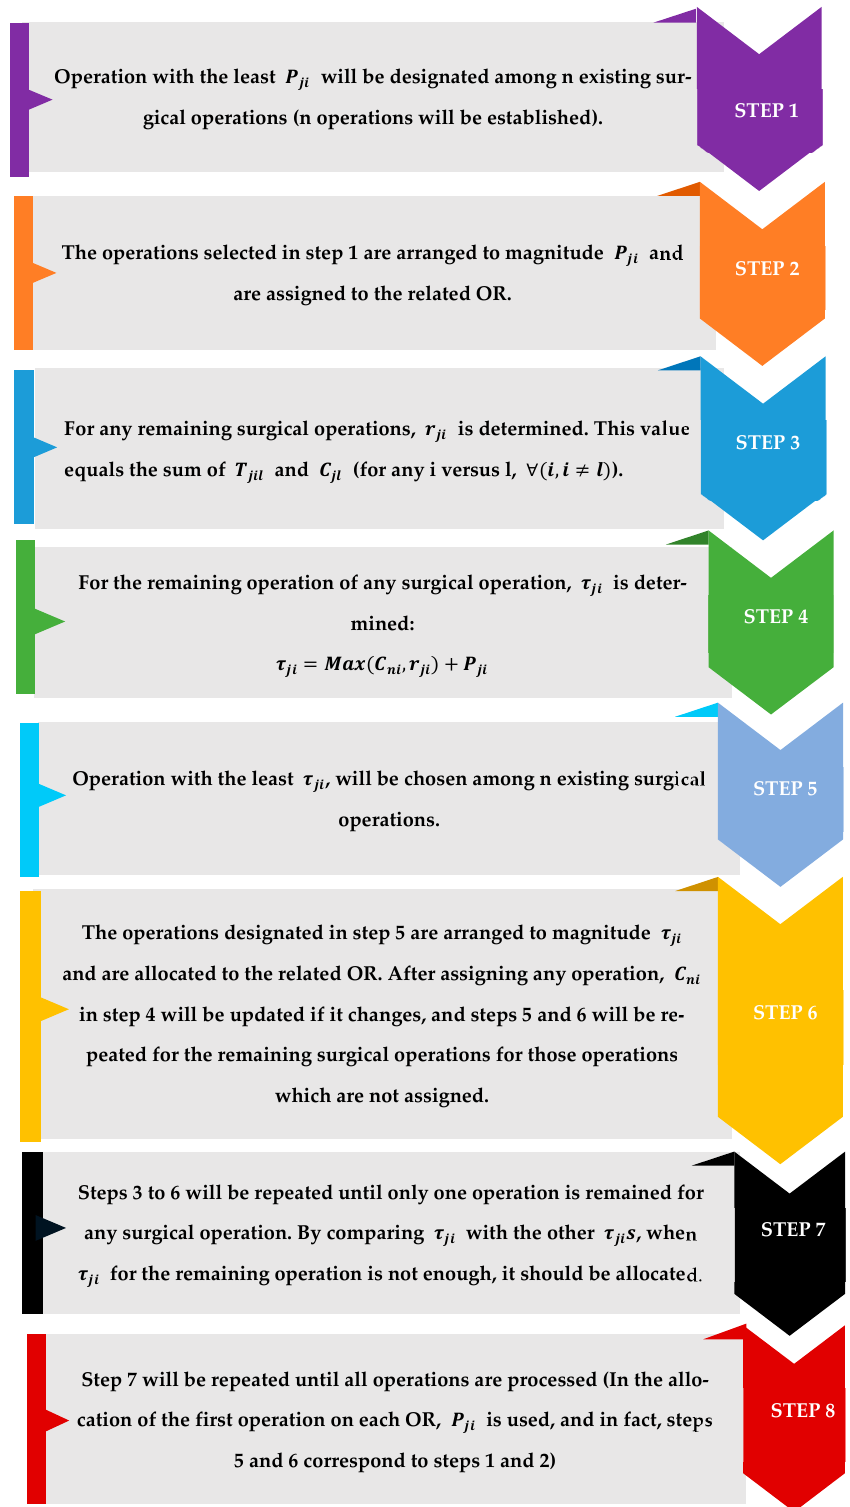
Figure 4. Flowchart for 8 steps of the suggested heuristic algorithm to solve the O | TTJD , MT | C max